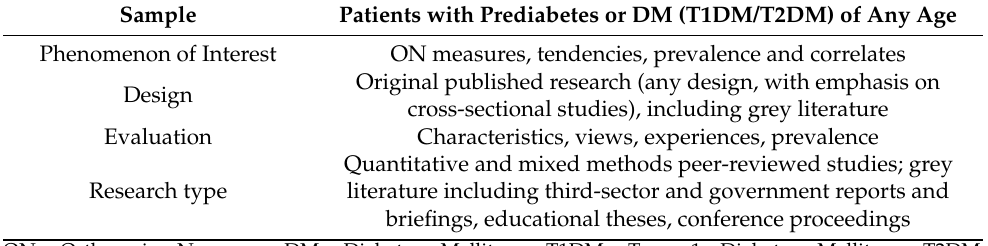
Table 2. The components of the SPIDER framework used for the identification of relevant studies.